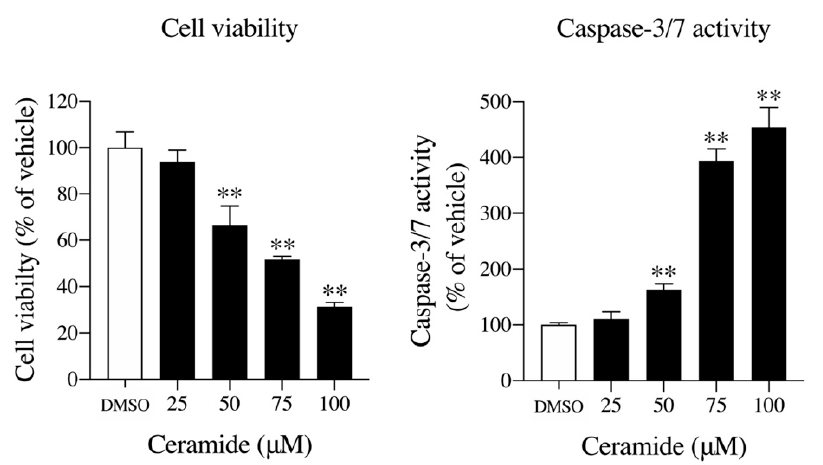
Figure 5. The effects of ceramide on cell viability and caspase-3/7 activity in U251MG cells. Cells were pre-incubated with various concentrations of ceramide for 12 h, and then the cell number and caspase- 3/7 activity were measured. The results are given as a percentage of the findings in the vehicle control (DMSO). Each column represents the mean ± SD ( n = 4). ** p < 0.01 compared to the vehicle control (DMSO).